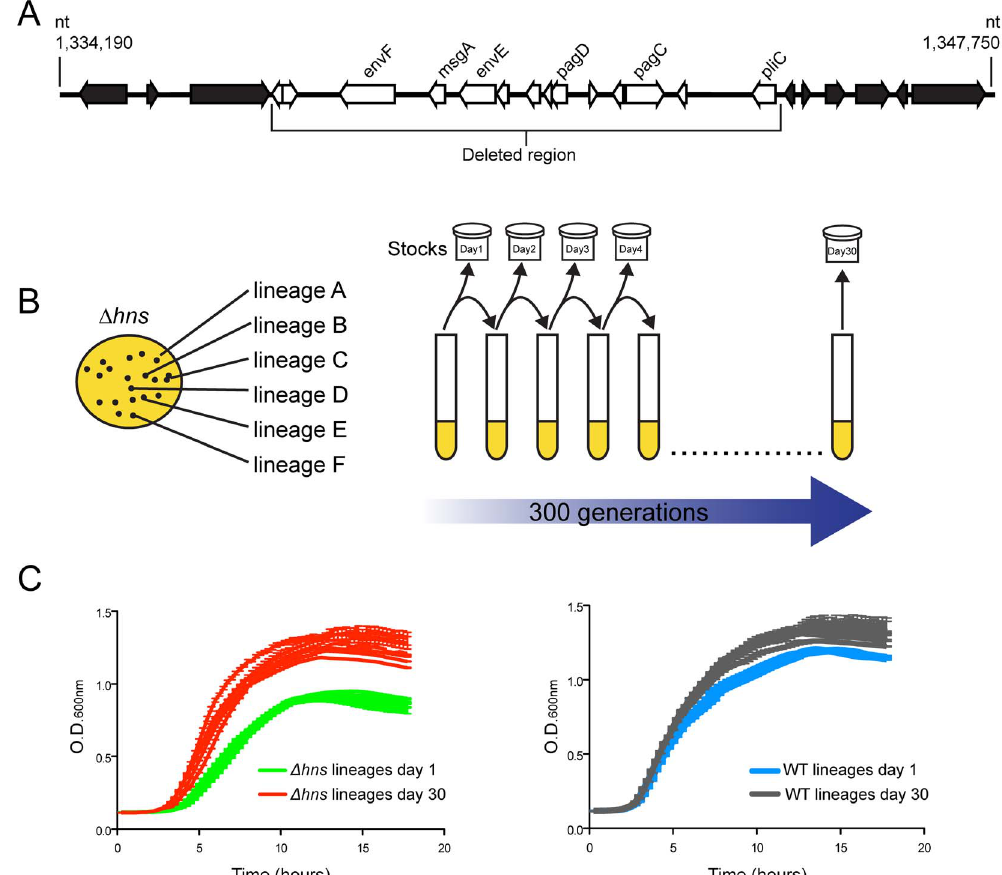
Figure 1. Experimental evolution of S. Typhimurium hns mutants. (A) An hns mutant isolate prepared for microarray analysis incurred a spontaneous 10 kb deletion after minimal laboratory passage. The white arrows represent the deleted open reading frames (ORFs) and the black arrows represent the ORFs adjacent to the deleted region. (B) Schematic diagram illustrating the experimental design of the serial passaging experiment. Six independently derived S. Typhimurium hns mutant colonies were selected to initiate cultures of LB media, named D hns lineages A–F. The D hns lineages were serially passaged in parallel with six wild type cultures for 30 days (approx. 300 generations) and samples from each lineage were stocked daily. Genomic DNA from each population at Day 1 and Day 30 of the evolution period was prepared for Illumina sequencing. (C) Left hand side: growth curves of the hns mutant populations at day 1 (green curves) and day 30 (red curves) of the evolution period. Right hand side: growth curves of the wild type populations at day 1 (blue curves) and day 30 (grey curves) of the evolution period. Liquid growth assays were performed in a 96-well plate reader.